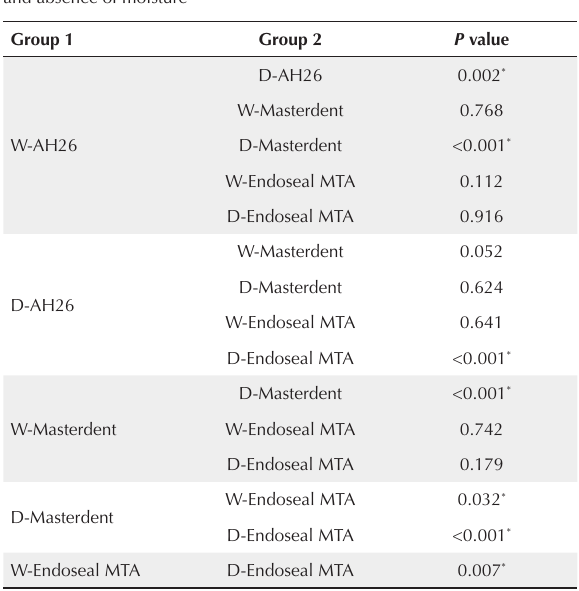
Table 2. Two by two comparisons of the leakage of all sealers in the presence and absence of